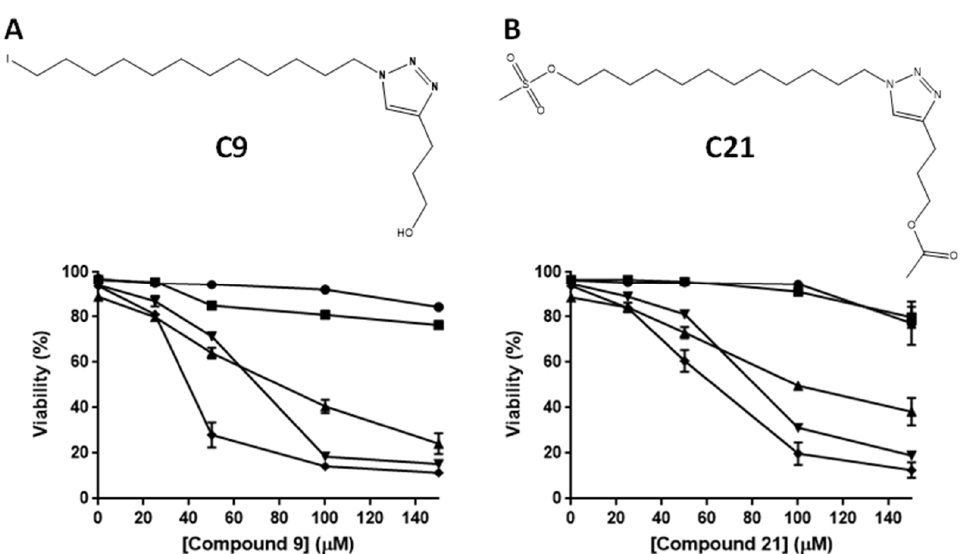
Figure 2. Effects of the alkyltriazole compounds C9 and C21 on the viability of different myeloblastic and lymphoblastic leukemia lineages. Lineages cells at 2 × 10 5 cells/mL were used. Cells were exposed to concentrations ranging from 0 to 150 µ M for 24 h, and cell viability was assessed by annexin V ‐ FITC/PI staining and flow cytometric analysis. ( A ) Chemical structure of C9 , with a hydroxyl group and an iodine atom as substituents. ( B ) Chemical structure of C21 , with an acetate group and a methanesulfonate as substituents. → Kasumi-1 (acute myeloblastic leukemia), (cid:4) → K562 (chronic myeloblastic leukemia), (cid:78) → ARH-77 (plasma cell leukemia), (cid:72) → Jurkat (acute lymphoblastic leukemia); (cid:4) → CCRF-CEM (acute lymphoblastic leukemia). These results are the mean ± SEM of three independent experiments performed in